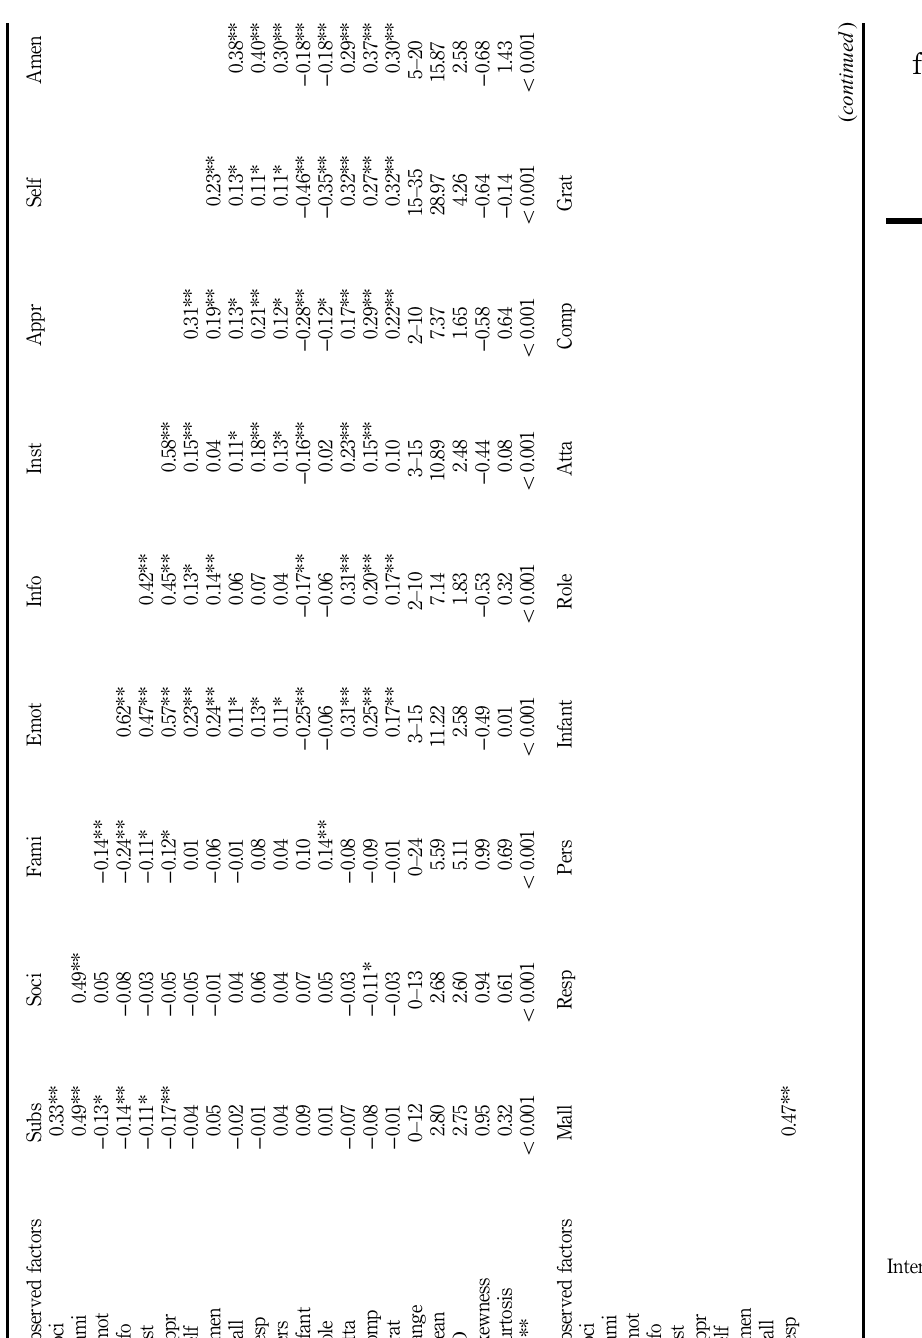
Table II. Intercorrelation matrix and descriptive statistics of each observed